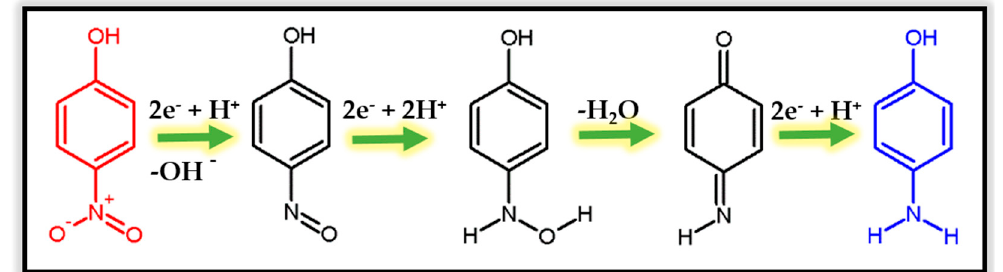
Figure 4. Involvement of six-electron in the conversion reaction of PNP to PAP. Adapted from [128], with permission from Elsevier, 2018.